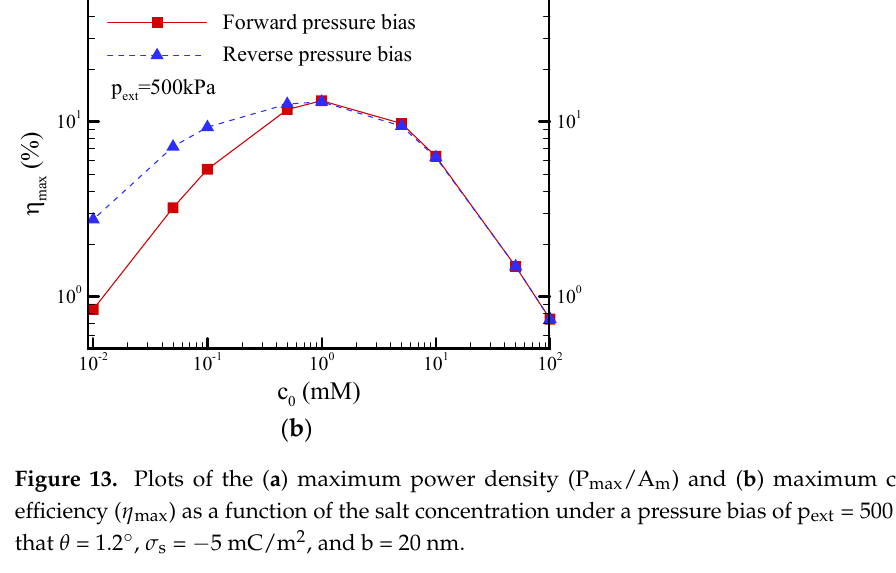
/A ) and ( b ) maximum conversion effi- max m = 500 kPa. Note that ext